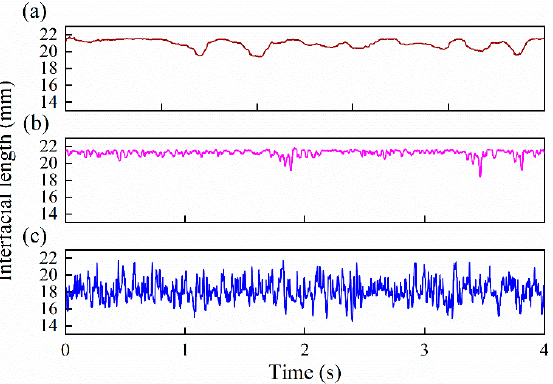
Figure 22. Time series of the interfacial length under typical flow conditions (0°): ( a ) U sw = 0.184 m/s, U so = 0.162 m/s, ST; ( b ) U sw = 0.368 m/s, U so = 0.552 m/s, ST&MI; ( c ) U sw = 0.737 m/s, U so = 0.921 m/s, D W/O&D O/W.